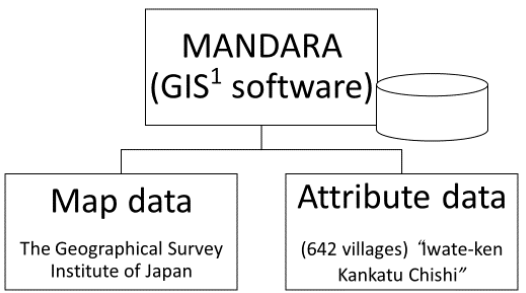
Figure 2. Methodology of the study. 1 GIS: geographic information systems.